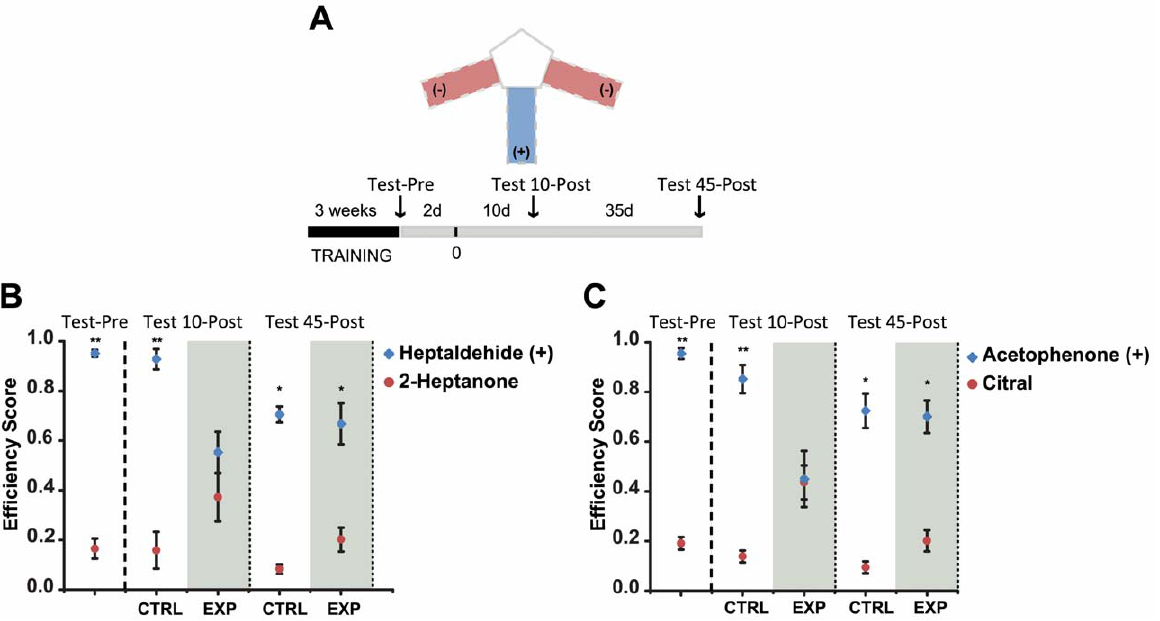
Figure 6. Memory of an olfactory discrimination task is recovered after the regeneration. A , Diagram of the three-arm maze and temporal course of the experiments is shown. B and C , Performance in the discrimination task pre- and post-methimazole administration in group 1 and group 2 respectively. Both groups discriminate the odorants after training (Test-Pre) (** denotes P , 0.01). Ten days after methimazole treatment the experimental group (EXP) fails to perform the task ( P . 0.05), 45 days post lesion, mice recover the ability to perform the task (* denotes P , 0.05).